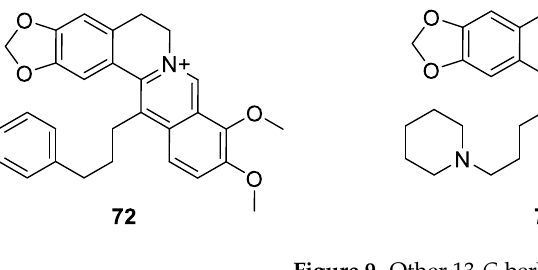
Figure 9. Other 13- C -berberine derivatives.